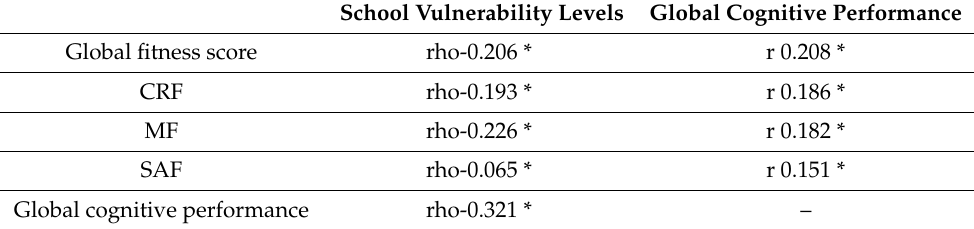
Table 2. Zero-order correlations among principal study variables. School Vulnerability Levels Global Cognitive Performance Global fitness score